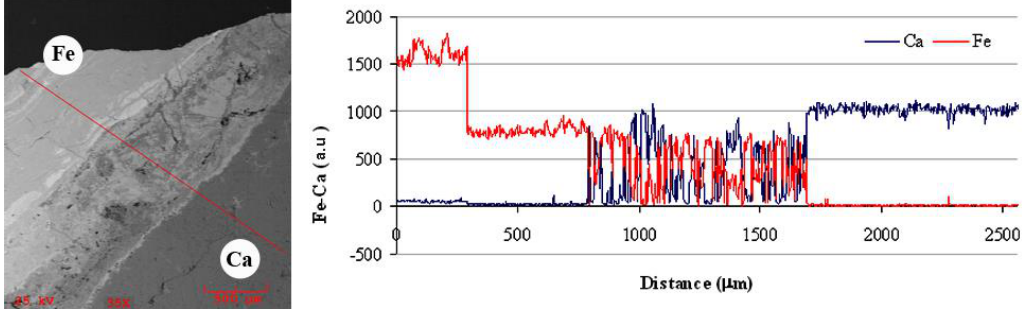
Figure 4. SEM image ( left ) and elemental line mapping ( right ) of iron and calcium obtained for the NS1 samples.